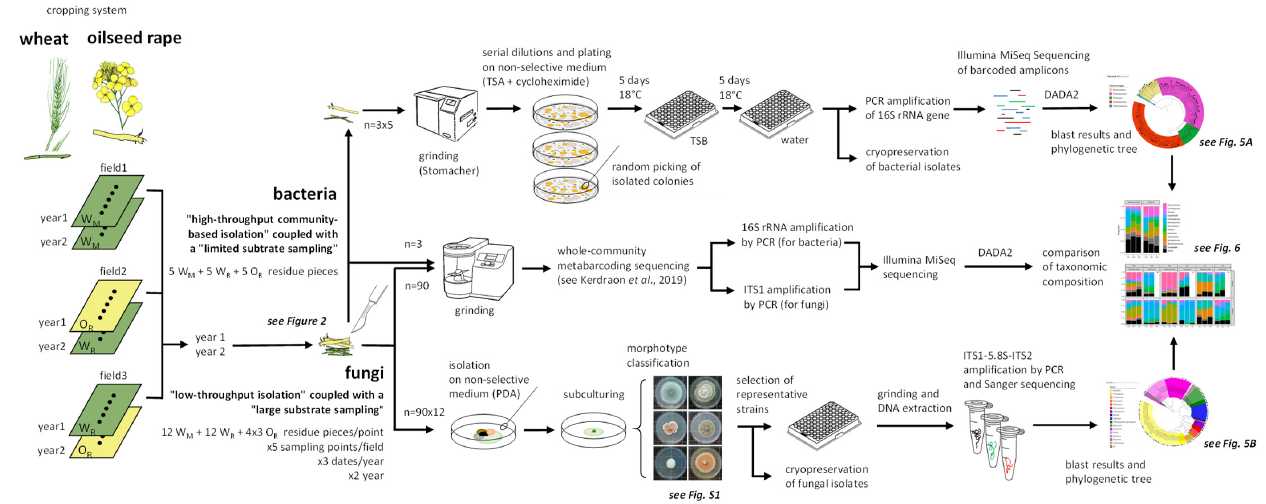
Figure 2. Overview of the culture-dependent molecular identification and whole-community metabarcoding strategies for characterizing and comparing the bacterial and fungal communities of wheat (W) and oilseed rape (O) residues.